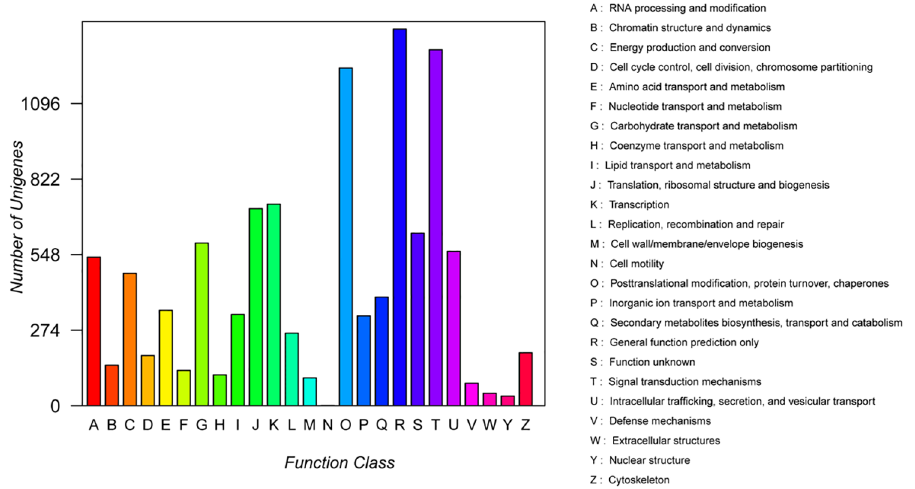
Fig 4. KOG functional classification of C . officinalis unigenes. A total of 10808 unigenes with significant homology to the KOG database (E-value (cid:20) 1.0 E -5 ) were classified into 25